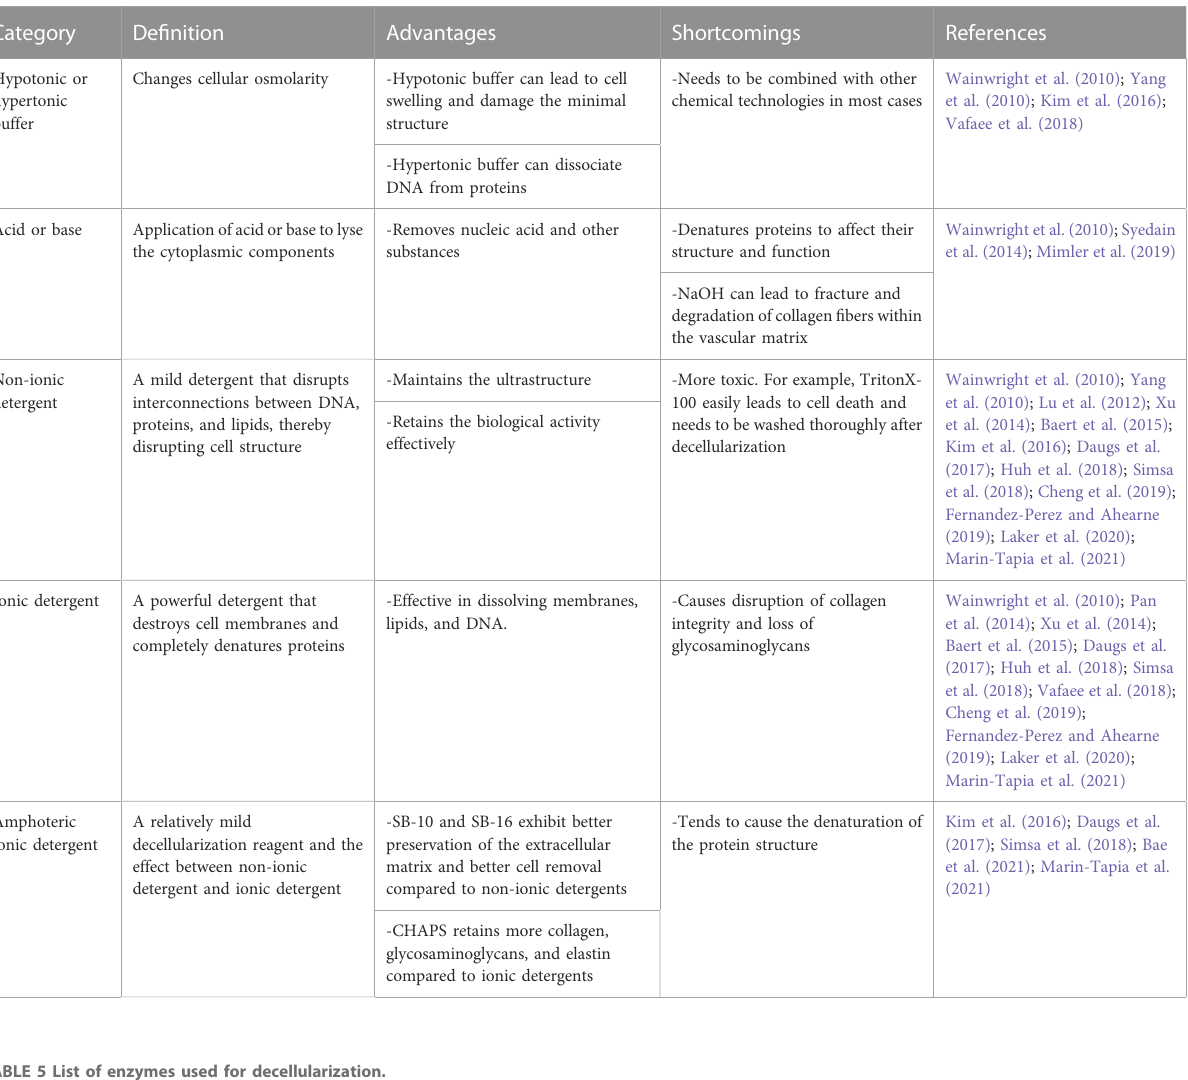
TABLE 4 List of chemical treatments used for decellularization.